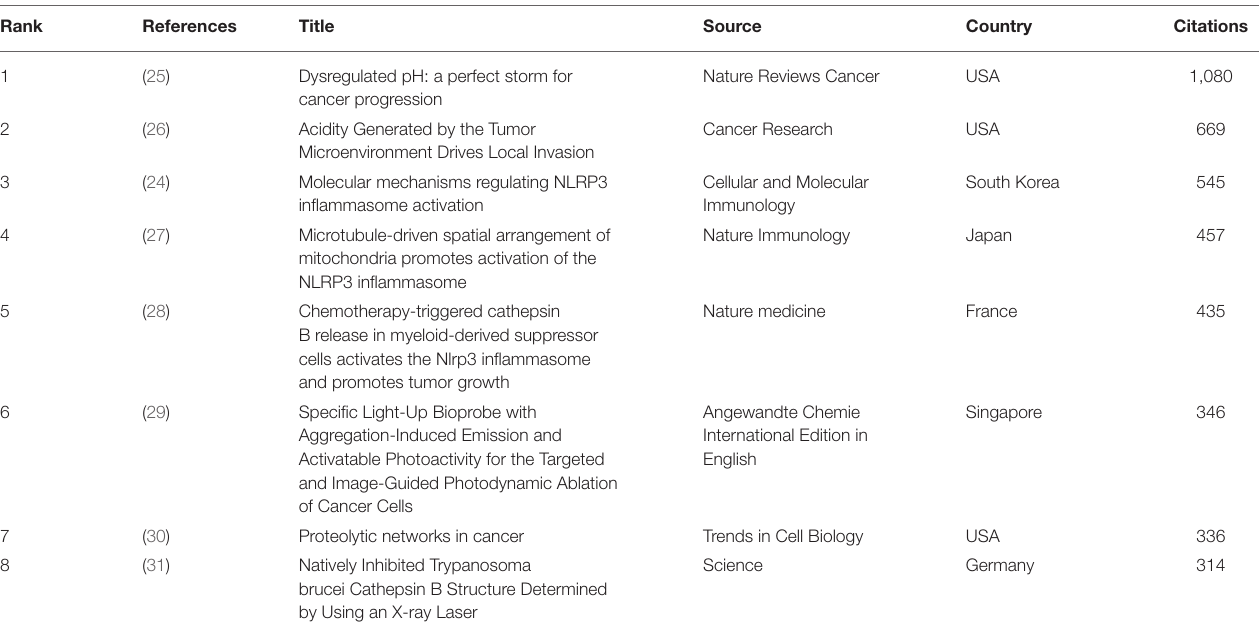
TABLE 1 | Top eight citation analysis of publications on CTSB